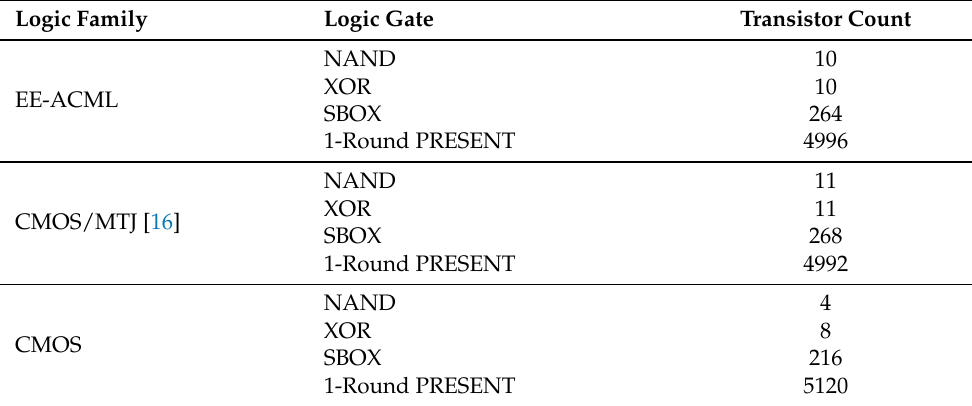
Table 4. Device counts of various CMOS, CMOS/MTJ, and EE-ACML-based circuits.